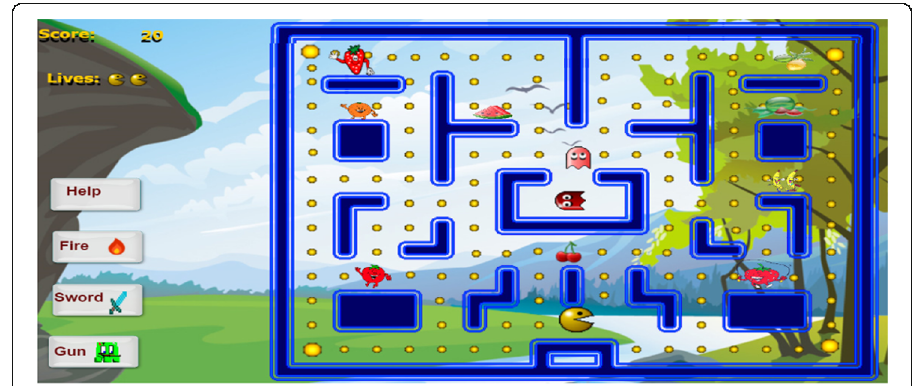
Fig. 6 Educational version of PacMan puzzle